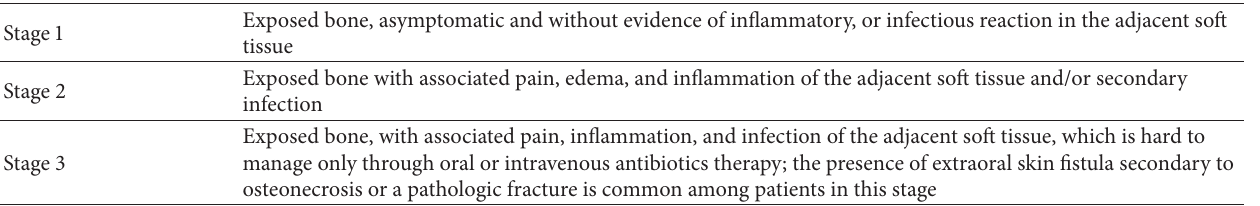
Table 1: Stages of BRON-J adapted from Ruggiero et al.